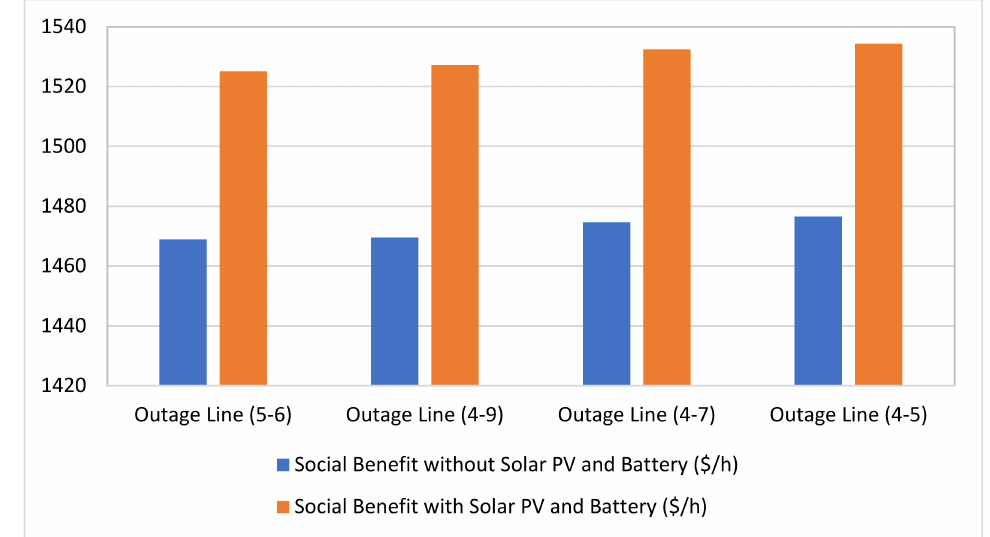
Figure 8. Social benefit with and without solar PV and battery system in IEEE 14 bus system using